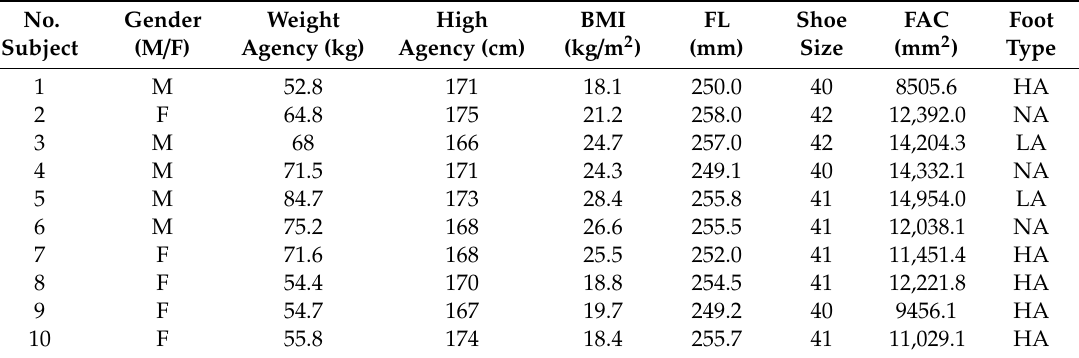
Table 2. A detail information of participated subjects in this study.